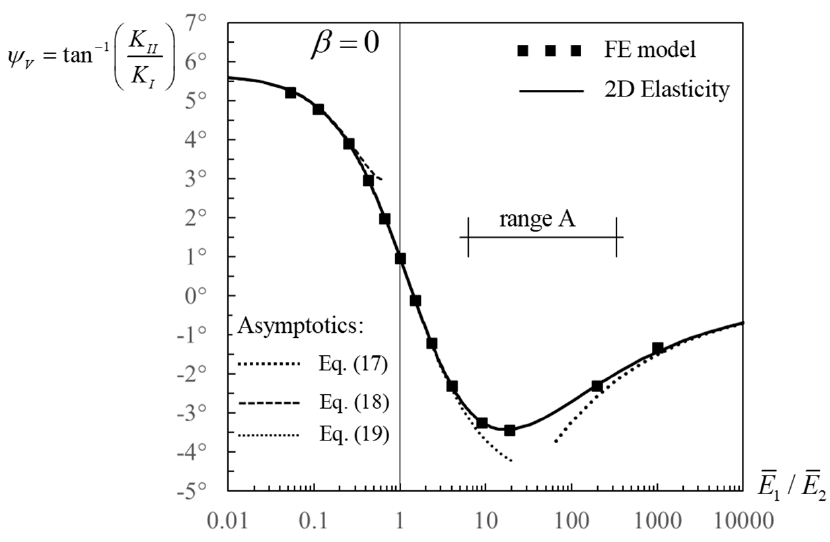
Figure 5. The mode mixity phase angle ψ V as a function of Σ = E 1 / E 2 . The analytical results are compared with numerical results and with the asymptotics and intermediate expansion in Equations (17)–(19). Range A is the interval where the asymptotics and expansions do not ensure uncertainties below 0.2 ◦ .